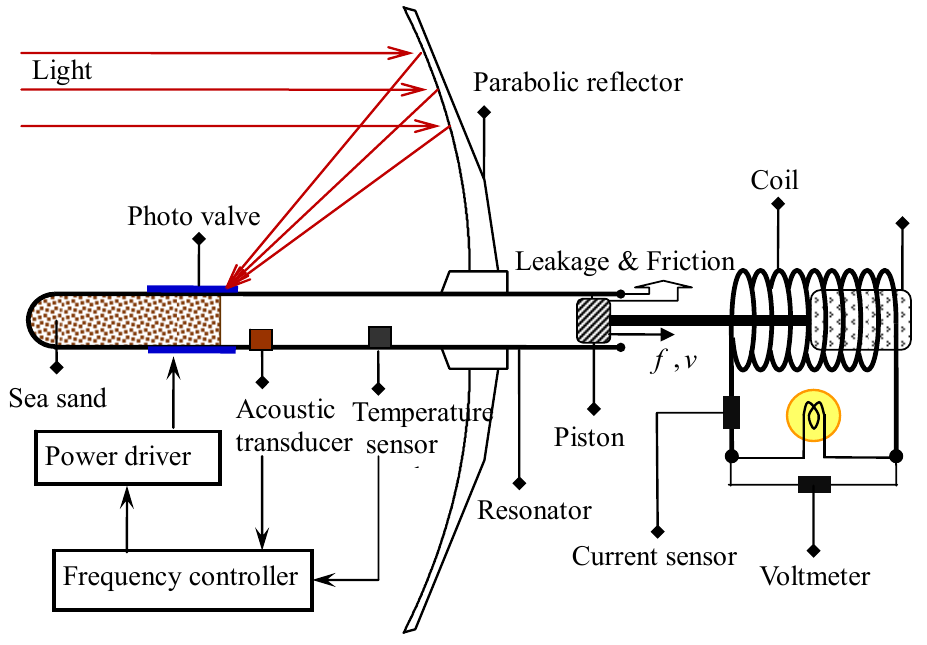
Figure 4. Active thermoacoustic solar-power